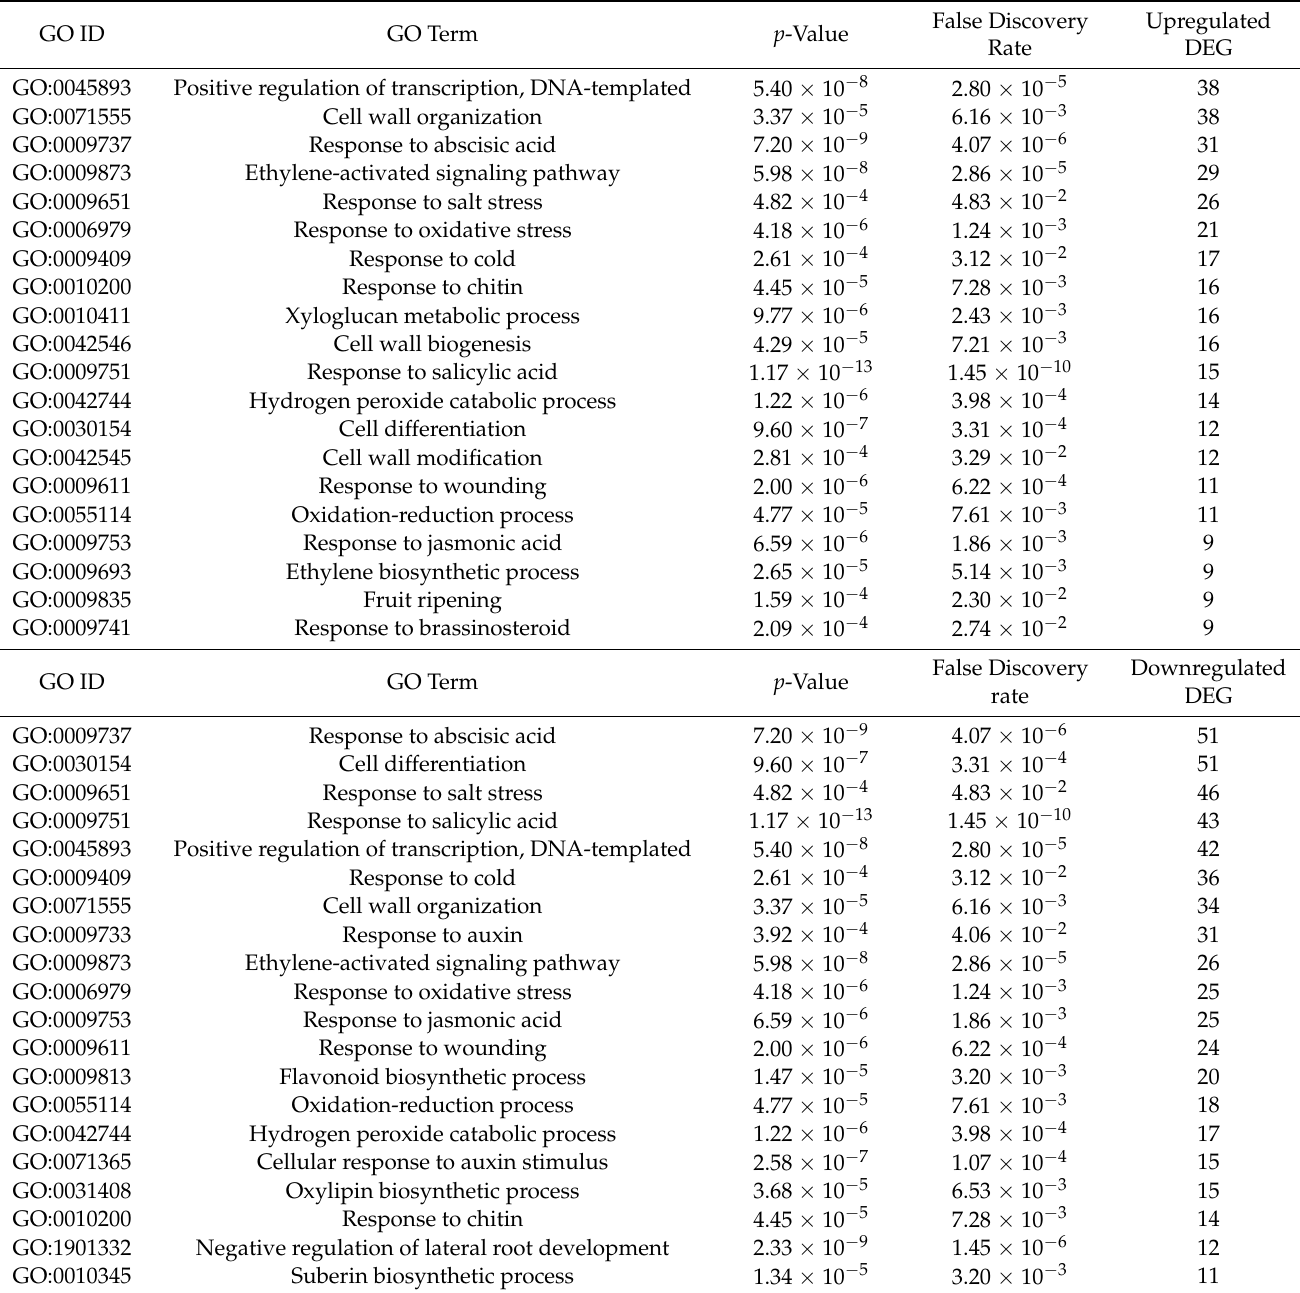
Table 1. The GO terms of banana 24 h after waterlogging